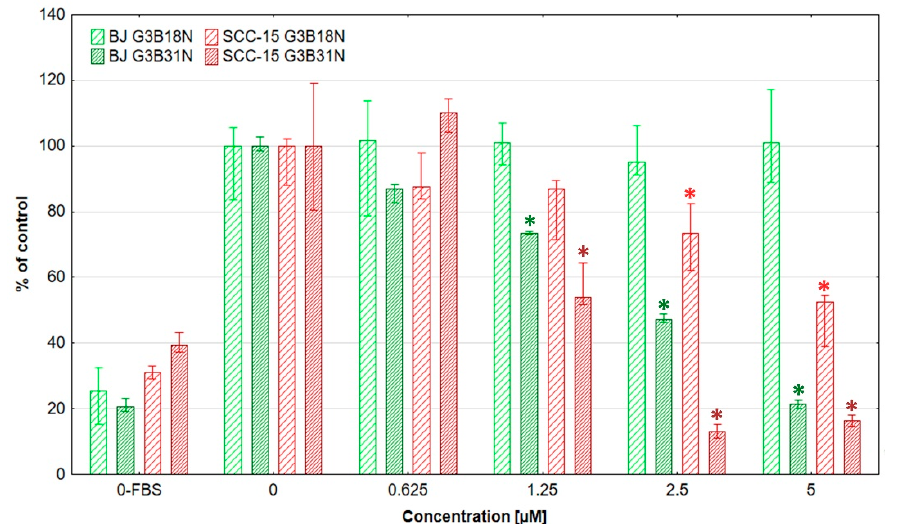
Figure 4. Proliferation rate of normal fibroblasts (BJ) and SCC-15 cells after 96 h incubation with dendrimer conjugates expressed as a percentage of non-treated control. 0-FBS indicate number of non-proliferating cells (deprived of FBS) as negative control. Bars are medians, and whiskers estimate lower and upper quartile values. * p < 0.05 indicate significant difference against control.